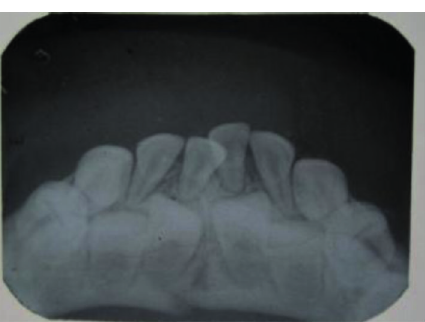
Figure 8: Postoperative followup.